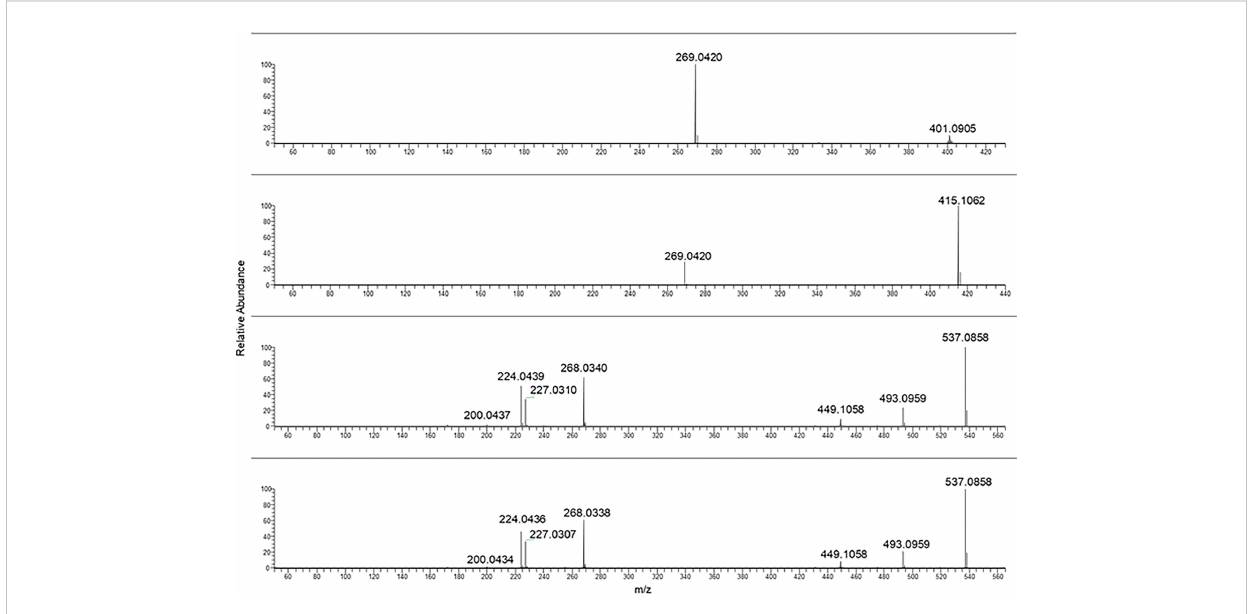
FIGURE 4 From the top to bottom: Frangulin B, frangulin A, sennidin B and A MS/MS spectra.